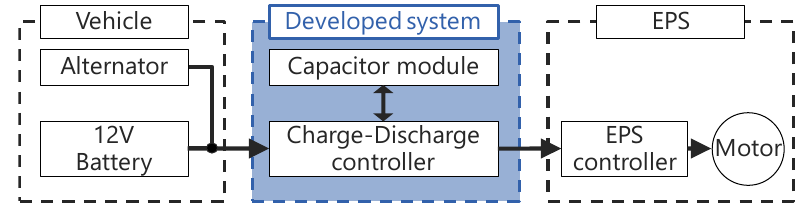
Figure 3. Configuration of auxiliary power supply system for EPS.